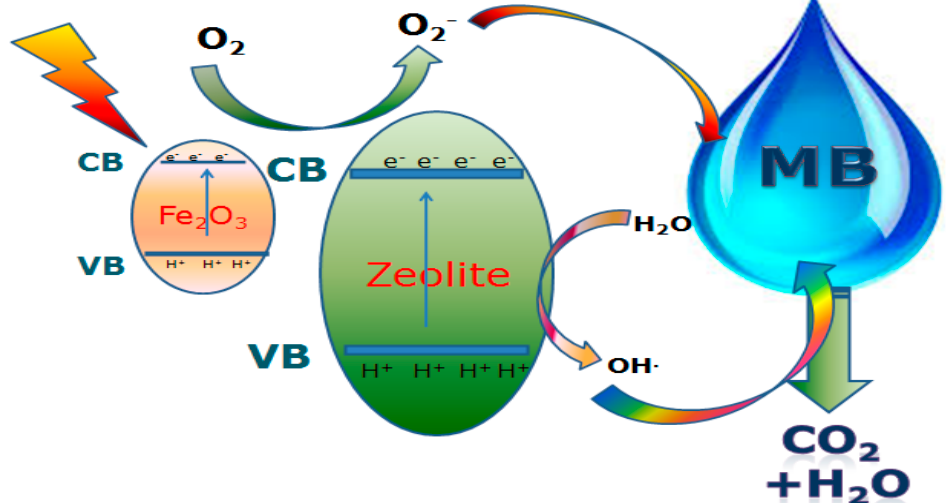
Figure 9. A schematic diagram of the proposed mechanism for MB photodegradation utilizing Fe 2 O 3 ‐ zeolite under sunlight illumination.